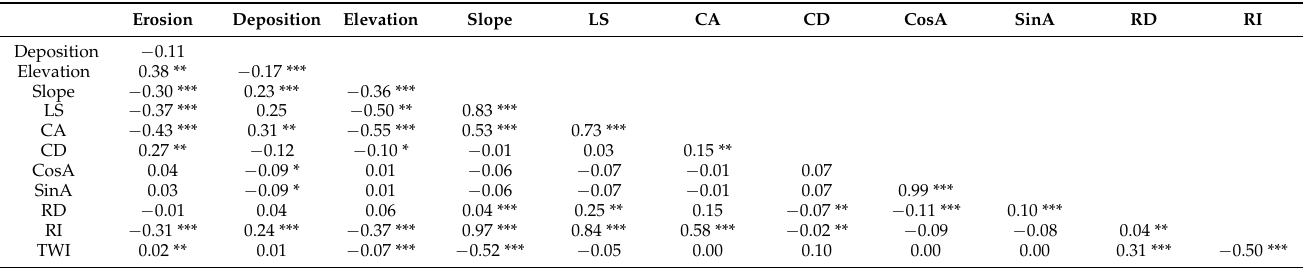
Table 3. Results of Pearson’s correlation analysis.